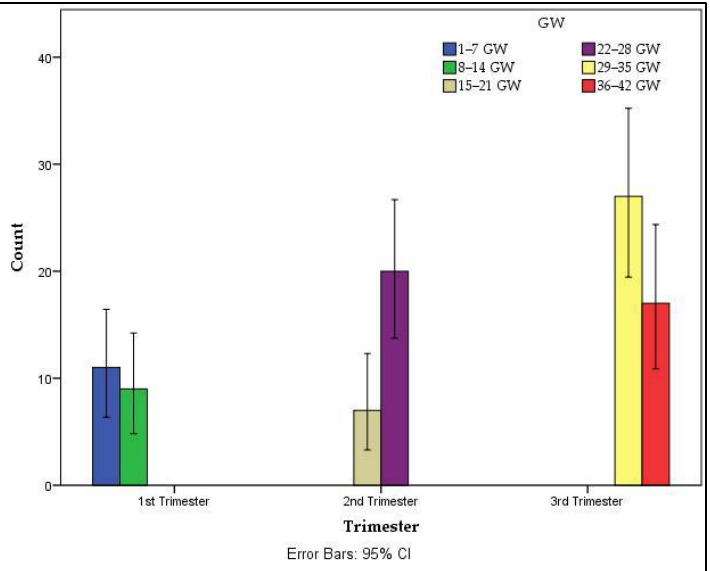
Figure 2. Distribution of vaccination with Pfizer/BioNTech based on the trimester of pregnancy. The x -axis represents the trimester of pregnancy/gestational weeks and the y -axis represents the count of vaccinated pregnant women; GW — Gestation Weeks.